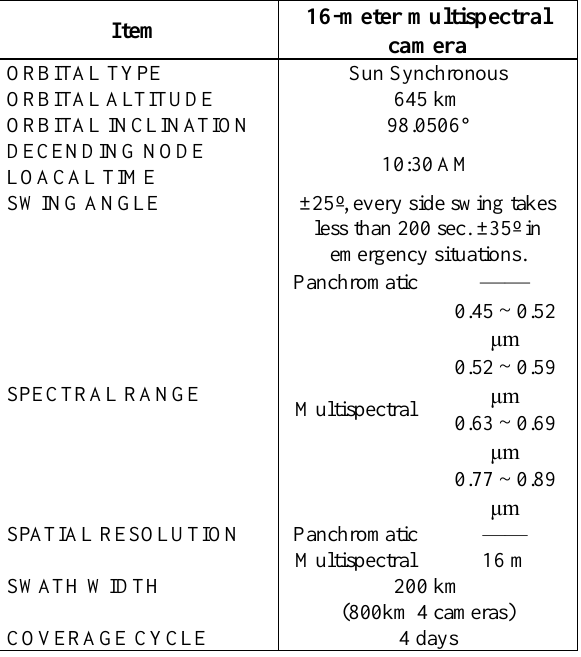
Table 1. Parameters of GF-1 satellite and its WFV camera.